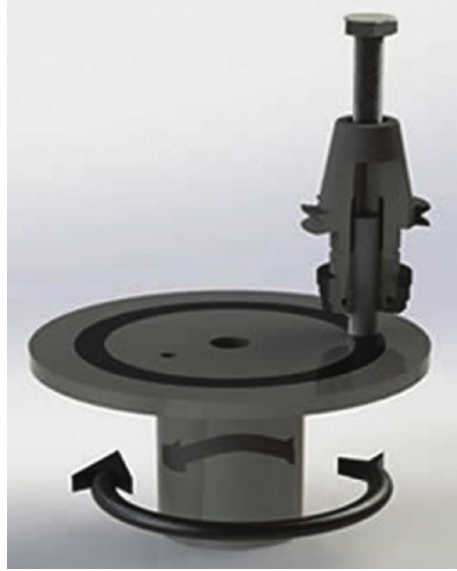
Figure 1: Schematic diagram of wear test